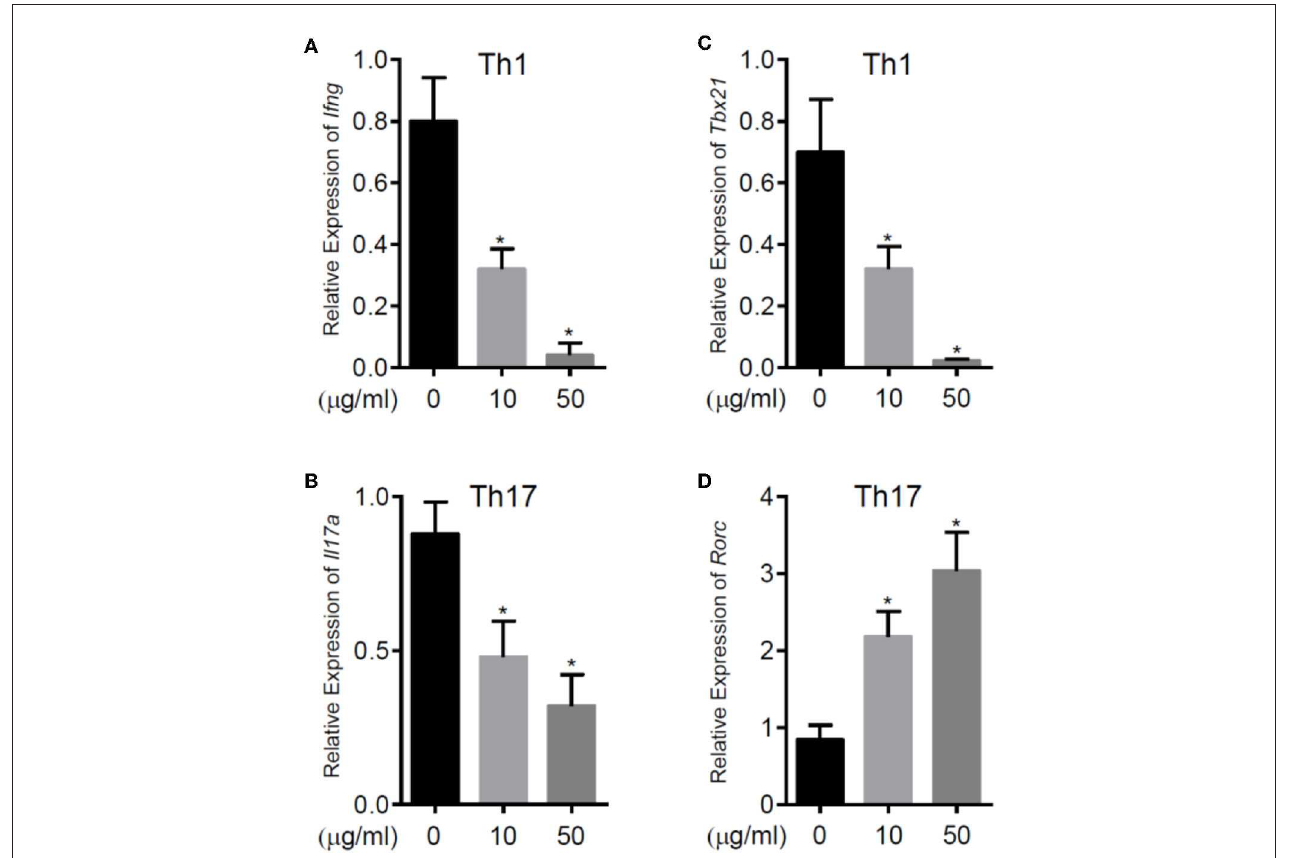
FIGURE 4 | The relative RNA expression of Ifng (A) and Tbx21 (C) in murine Th1 cells, Il17a (B) and Rorc (D) in murine Th17 cells. RNA was extracted from murine CD4 + T cell subsets polarized for 3 days with or without zebularine and evaluated by qRT-PCR. N = 5, * P < 0.05.